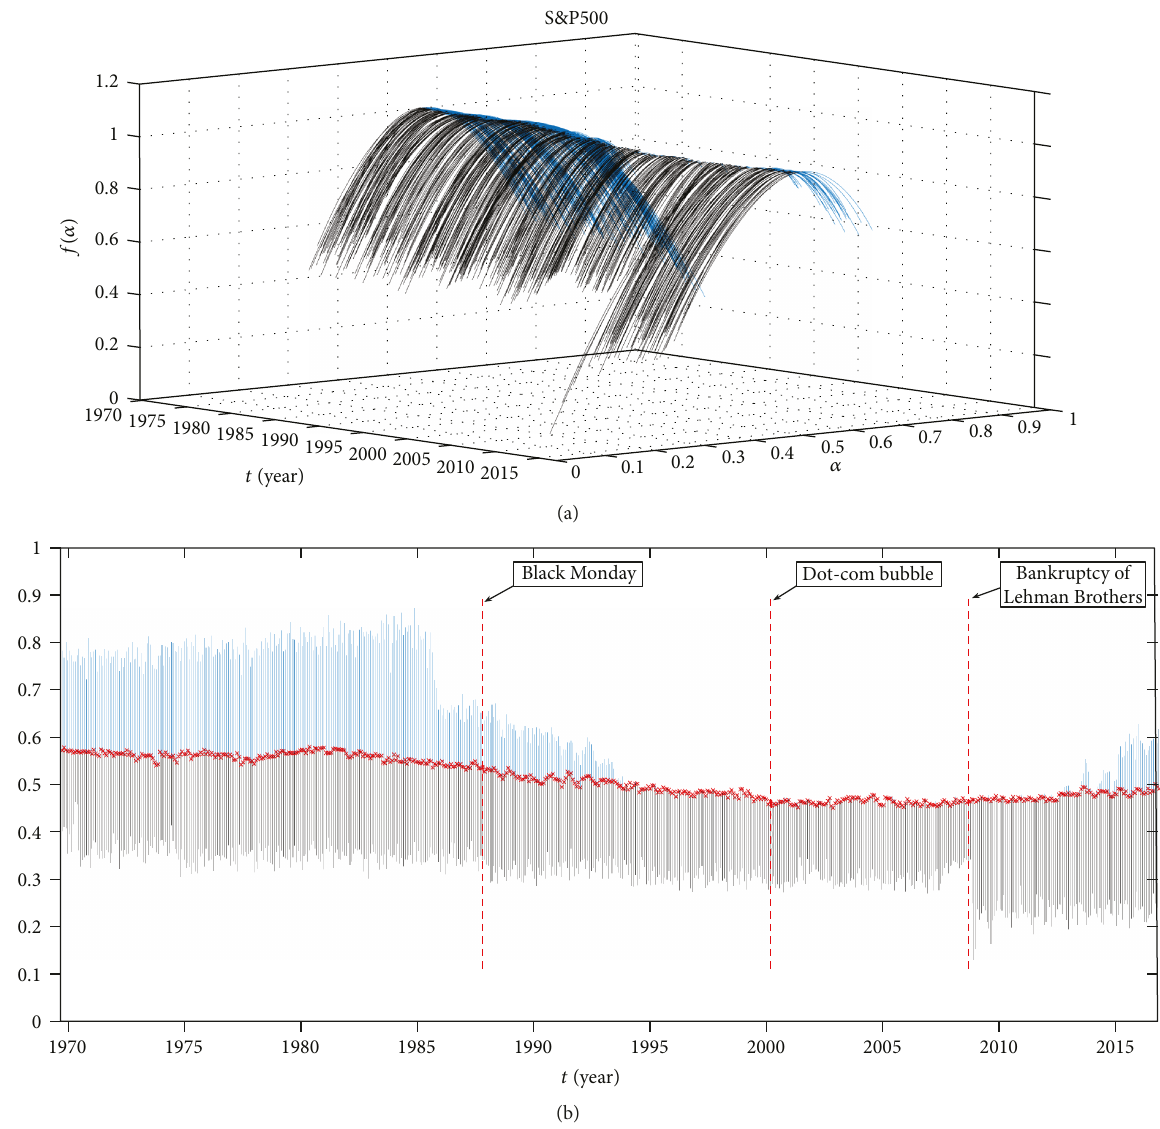
Figure 2: (a) For the S&P500 from January 03, 1950, to December 29, 2016, the sequence of singularity spectra f α calculated within a rolling 20-year window. The calendar date assigned to each f α corresponds to the end point within a window. This window is moved with the step of 20 points which corresponds approximately to one calendar month. The black sold line corresponds to the left and the blue line to the right side of f α . (b) Projections of f α of (a) onto the time t − α plane. The red line illustrates displacement of the maxima of f α in the consecutive windows. Vertical dashed lines indicate the Black Monday of October 19, 1987; burst of the Dot-com bubble in March 10, 2000; and bankruptcy of Lehman Brothers in September 15,